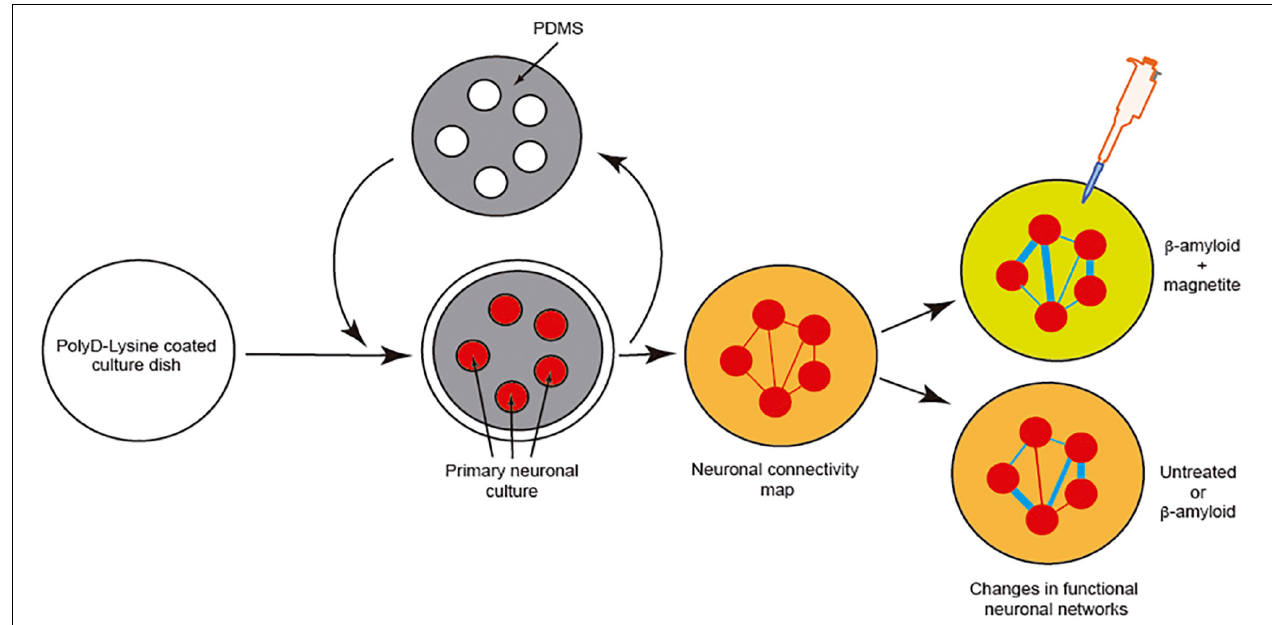
FIGURE 6 | Example of the analysis of neuronal network changes mediated by amyloids (A β ). We describe the experiment developed by Teller et al. (2015). In the experiment, the authors generated clusters of cells further interconnected in a network like the Atomium attraction in Brussels. After treatment with A β alone or A β -magnetite, the changes in the neural network were analyzed using NetCal TM software.